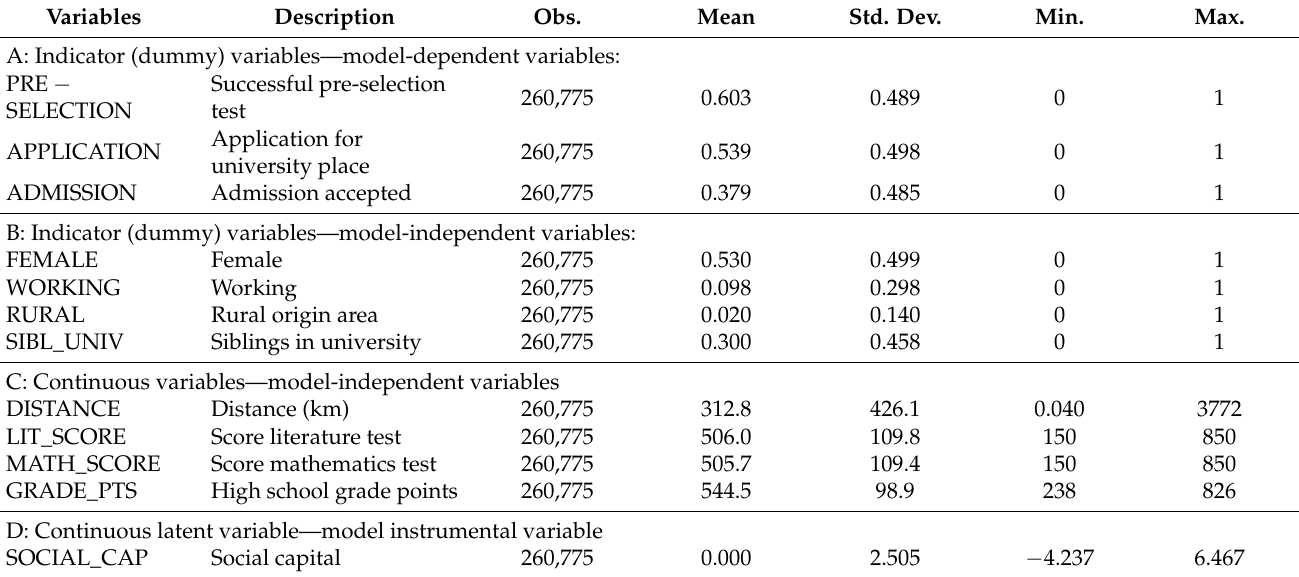
Table 1. Descriptive statistics for the sample of university